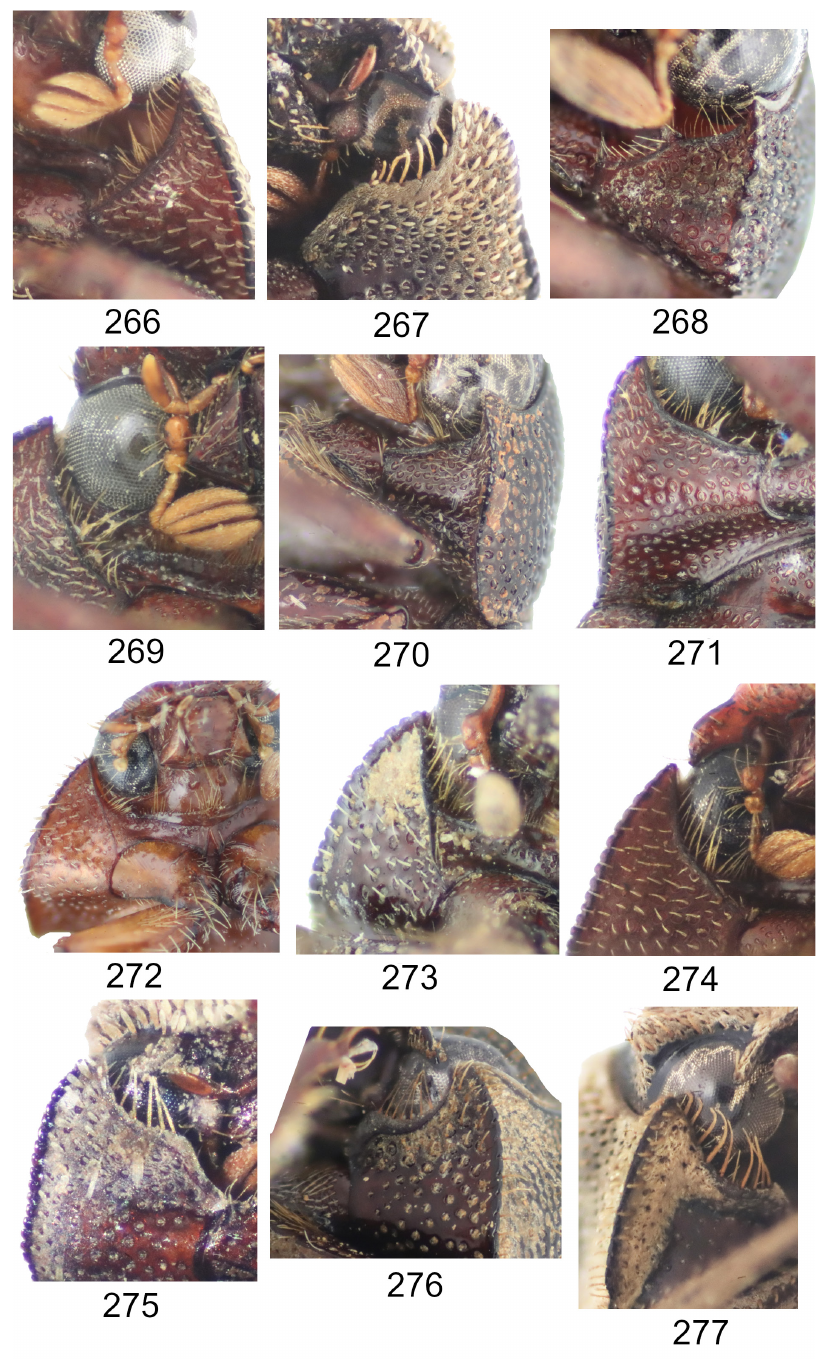
Figs 266–277. Papuan and Wallacean Maechidius Macleay, 1819, pronotal hypomeron,